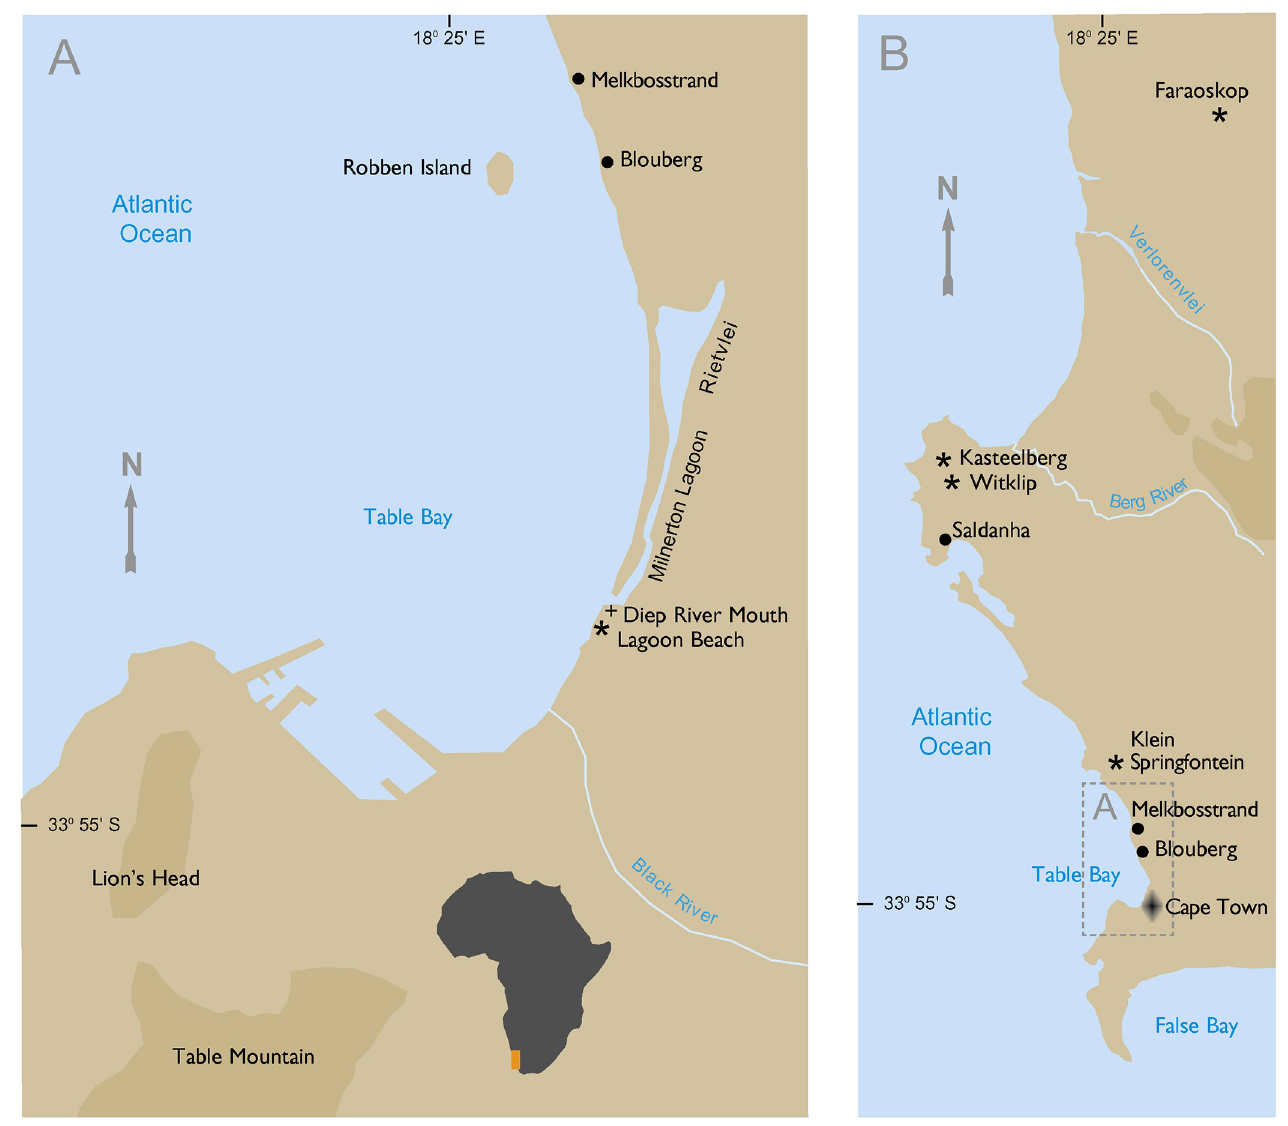
Fig 1. Map of the region, with key archaeological sites